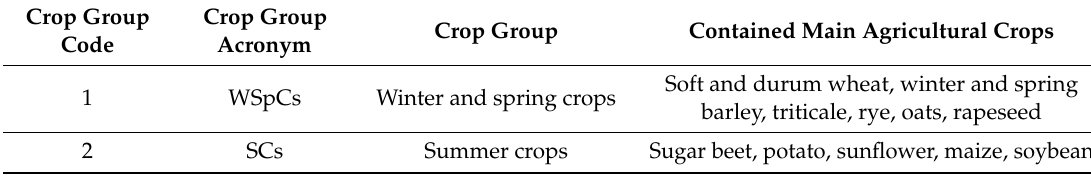
Table 2. Identified crops or crop